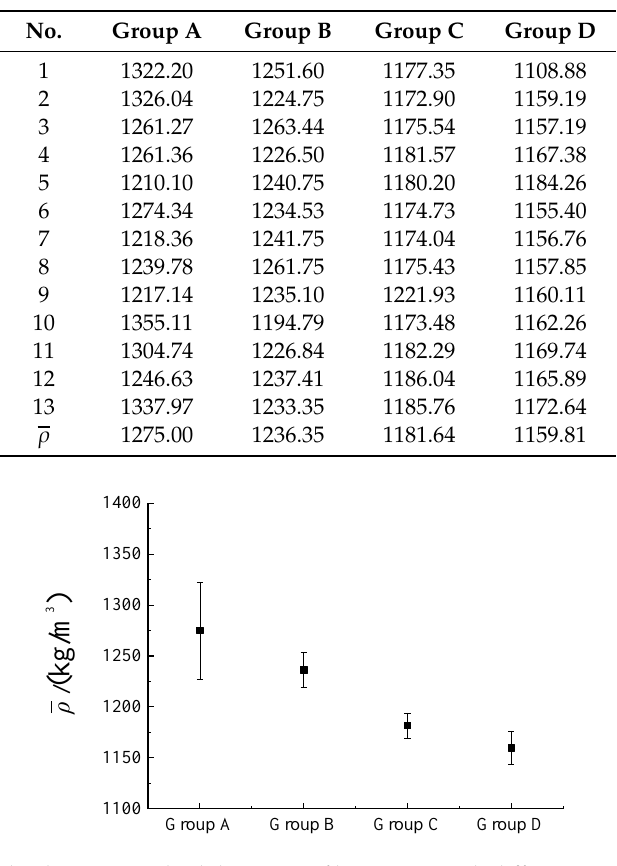
Figure 3. The density standard deviation of briquettes with different particle sizes.